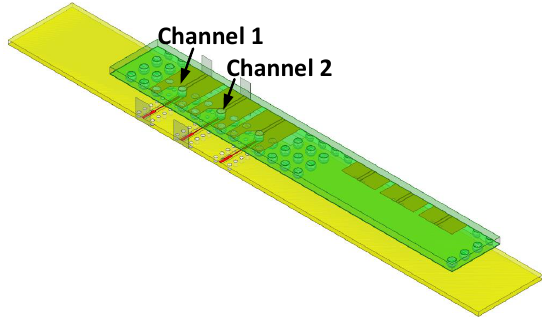
Figure 14. Three-dimensional model of the direct simulation for the package-board transition.